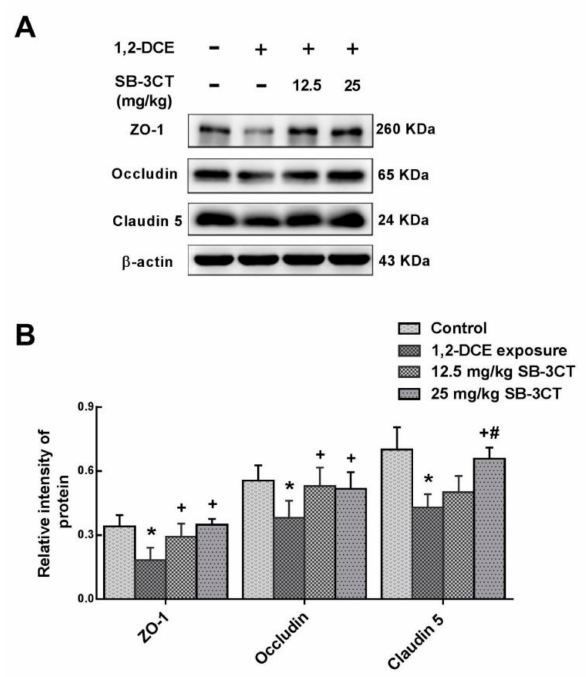
Figure 5. Involvement of MMP-9 in the decrease of TJs expression in 1,2-DCE-intoxicated mice. ( A ) Representative images of Western blot analysis. ( B ) Graphs show the densitometric quantitation of ZO-1, occludin, and claudin-5, which were normalized to the intensity of β -actin. Data expressed as mean ± SD are the results of five independent experiments and analyzed by one-way ANOVA. Significant di ff erence is defined as p < 0.05, and *, vs. control group; + , vs. 1,2-DCE poisoned group; # vs. low dose intervention